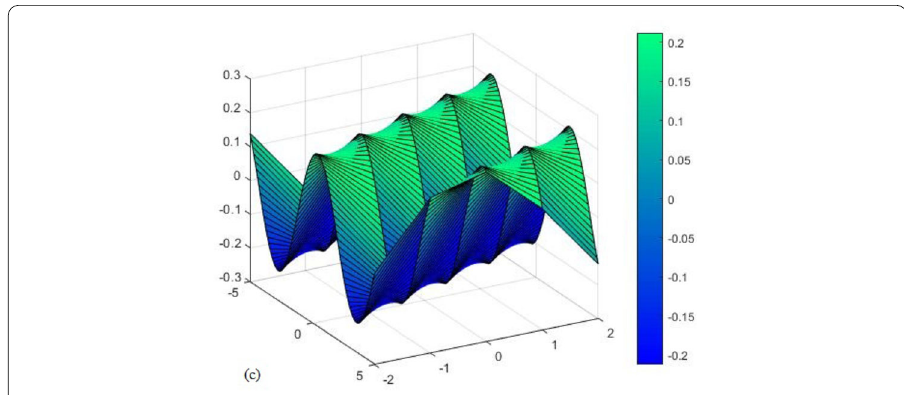
Figure 3 The graph of approximate solution ( e ) of (cid:11) ( χ , ϕ , η ) at ϒ = 0.4 of Example 1